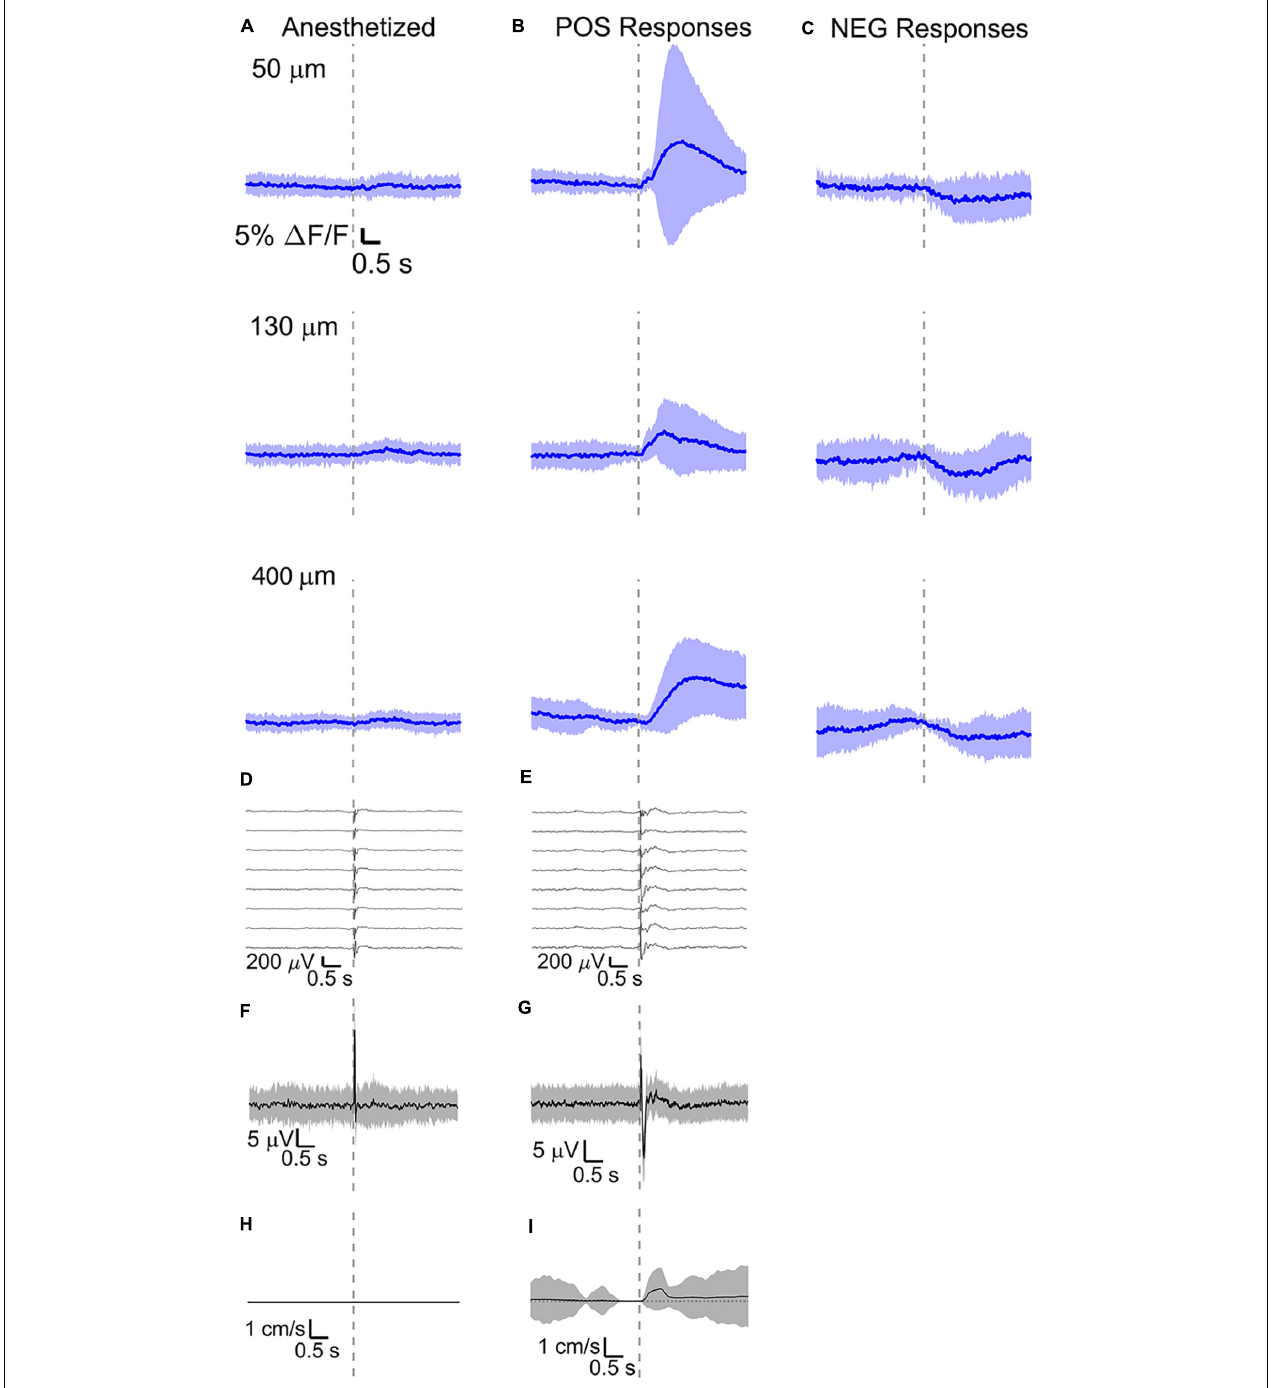
FIGURE 6 | Average calcium signal at three different depth and LFP, both in barrel cortex, ECoG, and running speed in response to a facial air puff (four anesthetized and awake but resting mice). Average calcium signals recorded from three different depths in (A) anesthetized (4 mice, 50 µ m: 236 trials, 55 ROIs, 130 µ m: 221 trials, 44 ROIs, 400 µ m: 228 trials, 50 ROIs) and awake but resting mice, the latter separated in (B) positive (4 mice, 50 µ m: 213 trials, 42 ROIs; 130 µ m: 227 trials, 42 ROIs, 400 µ m: 215 trials, 38 ROIs) and (C) negative signals (4 mice, 50 µ m: 213 trials, 15 ROIs; 130 µ m: 227 trials, 20 ROIs, 400 µ m: 215 trials, 20 ROIs). (D,E) Corresponding average LFP recorded by eight electrodes (every 4th channel of the linear probe, tip at 850 µ m below dura, bottom LFP trace: 800 µ m, top LFP trace: 100 µ m below dura, (cid:49) depth = 68 µ m between adjacent traces). Corresponding (F,G) average ECoG and (H,I) average speed. All traces are plotted as mean ± standard deviation. Gray dashed line marks the air puff